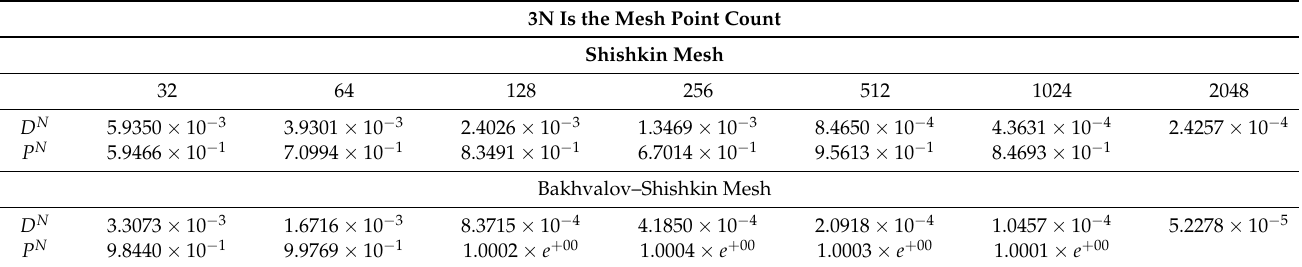
Table 2. Derived ε -uniform errors D N and orders of convergence P N for Example